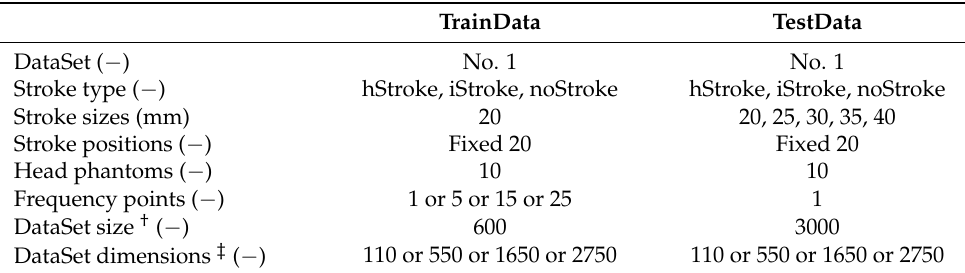
Table 4. Complete graphs of classification accuracy and cross-validation error for different dimension reductions are provided in Appendix B. Table 4. Training and testing data parameters for hypothesis H2.